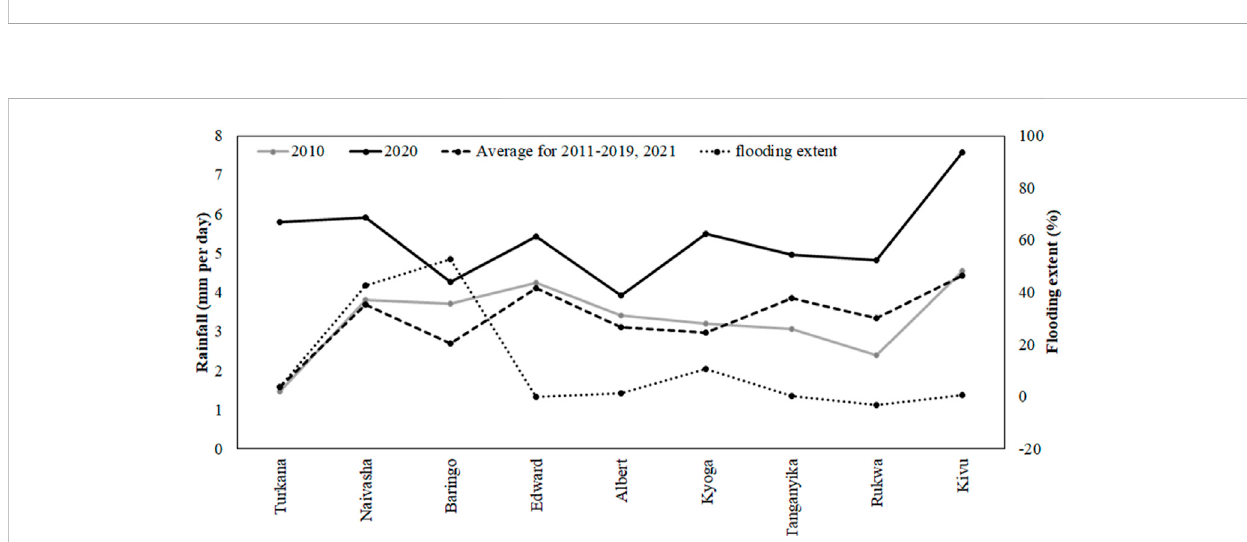
FIGURE 5 Amount of rainfall recorded in the years 2010 and 2020 compared to annual averages for other years and the aerial fl ooding extent of the studied lakes. Lake Victoria was exempted in the graph due to high precipitation differences of 1993 and 3,080 mm for 2010 and 2020,